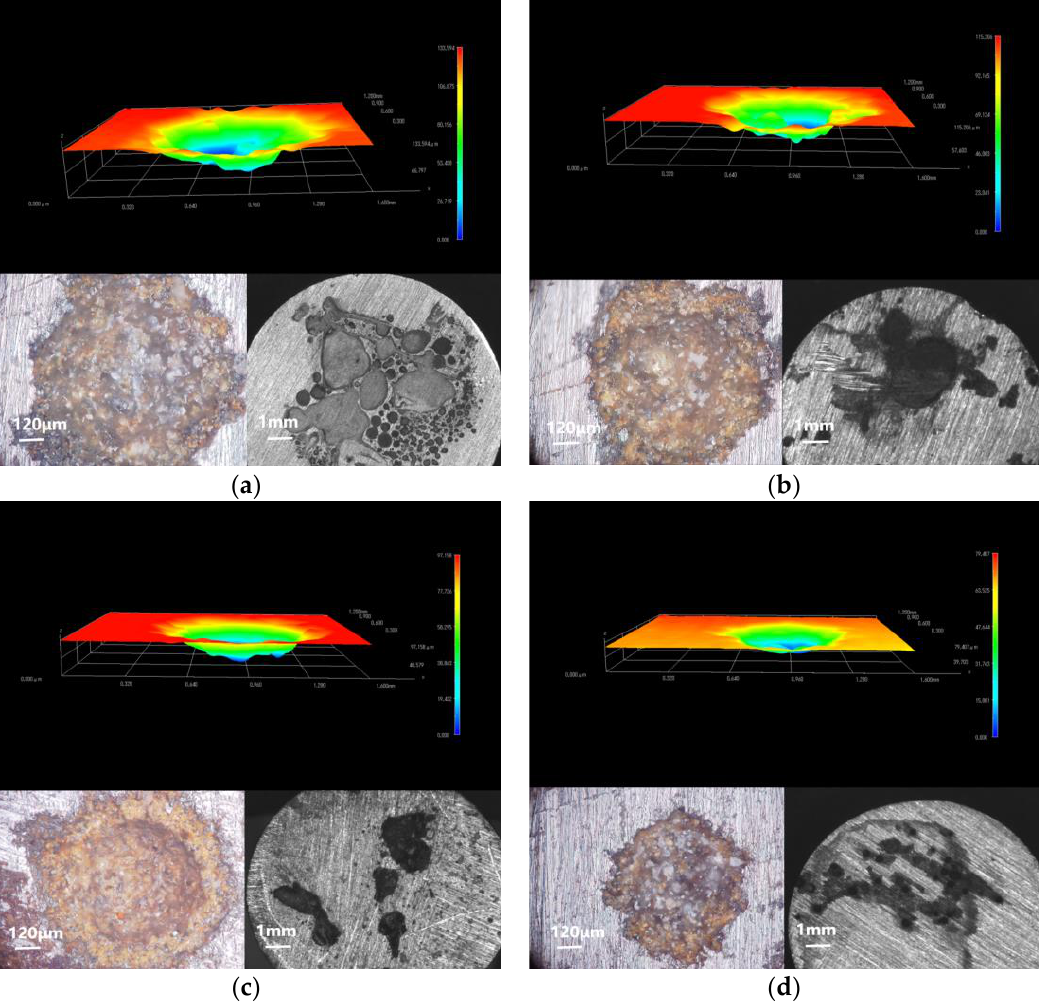
Figure 11. Three-dimensional stereo microscope image, 3D fitted morphology, and stereo microscope image of metal substrate immersed for 31 d: ( a ) C1; ( b ) C2; ( c ) C3; and ( d ) C4.